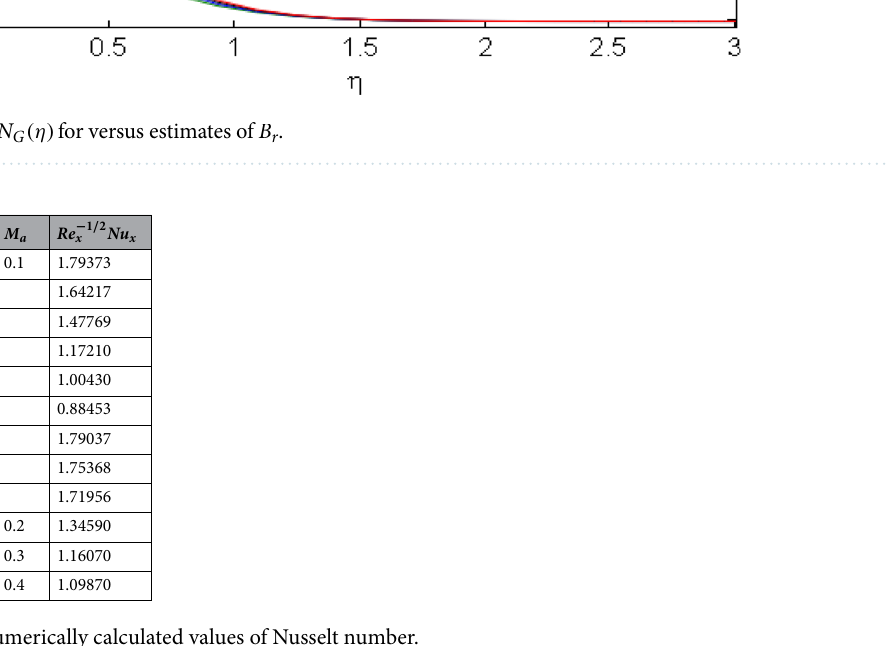
Table 2. Numerically calculated values of Nusselt number.